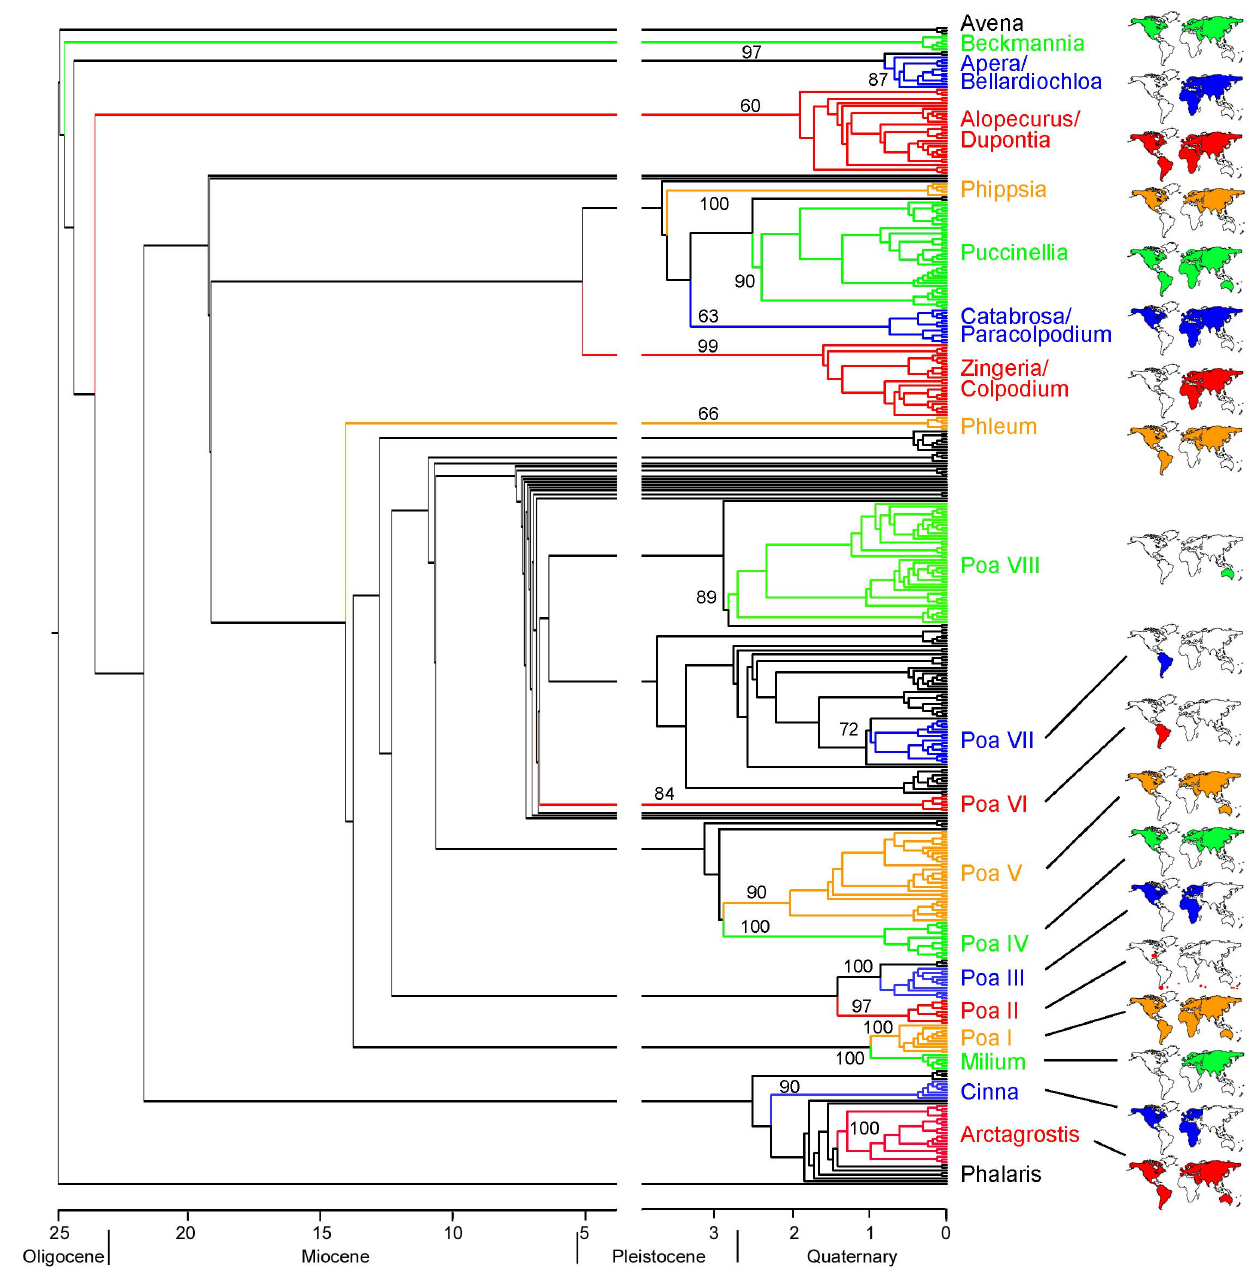
Figure 1. Simplified phylogram from maximum likelihood analysis of ribosomal ITS sequences in Poa and related genera. Bootstrap support for the major clades are indicated at the branches. Informal names of the clades are given in conjunction with their distribution. For taxon names see the phylogenetic tree in the figure S1.